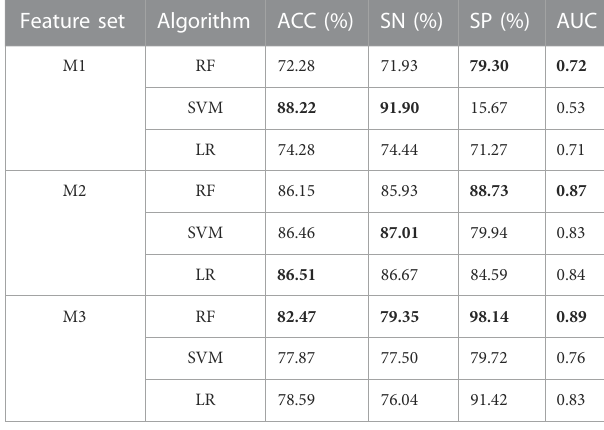
TABLE 4 Performance comparison of different